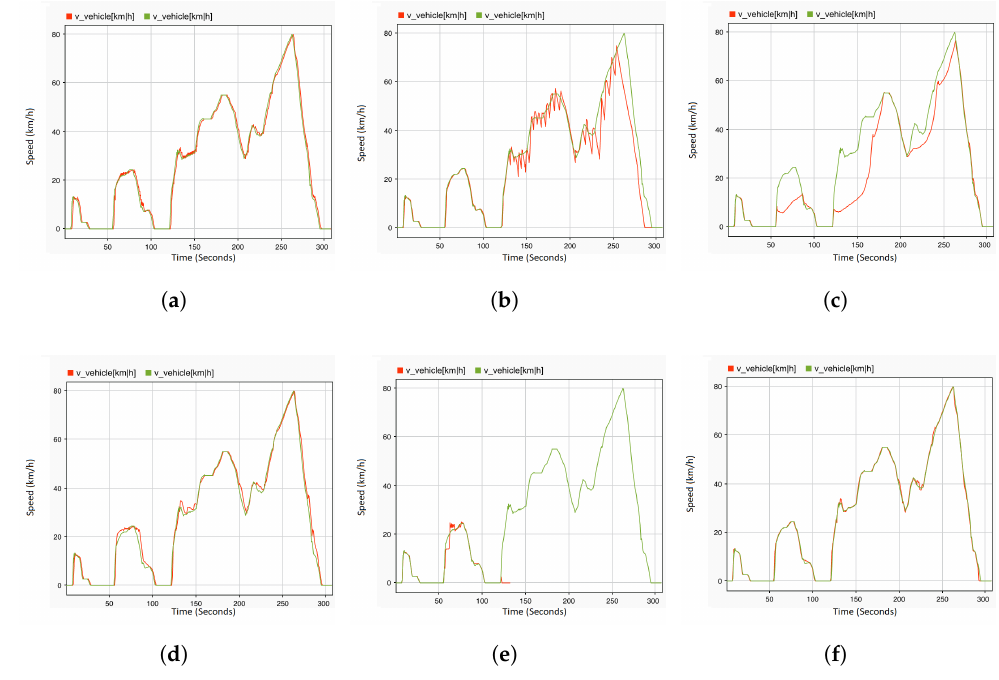
Figure 11. System output: vehicle speed under single permanent fault injection. ( a ) Acceleration pedal with gain fault. ( b ) Rail bar sensor packet with loss fault. ( c ) Engine RPM sensor with stuck-at fault. ( d ) Acceleration pedal with drift fault. ( e ) Mass flow through throttle with spike fault. ( f ) Engine RPM sensor with delay fault.